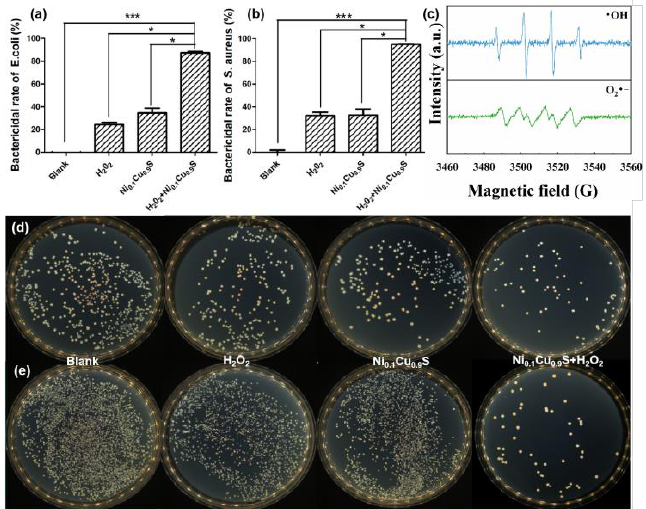
Figure 5. The bactericidal rate of Ni 0.1 Cu 0.9 S nanozyme against ( a ) Gram-negative E. coli and ( b ) Gram-positive S. aureus . Data are presented as the mean ± SD ( n = 3). * means p < 0.05, *** means p < 0.001. ( c ) EPR spectra of superoxide anion and hydroxyl radical in the reaction system. The colony plating images of different systems against ( d ) E. coli and ( e ) S. aureus .